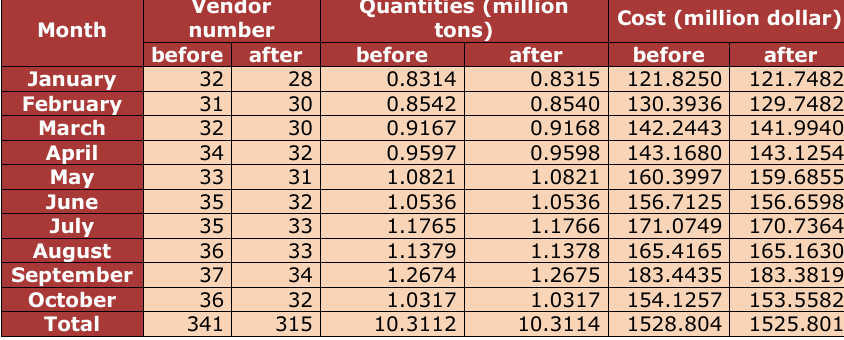
Table 5. Purchasing cost comparison of ball